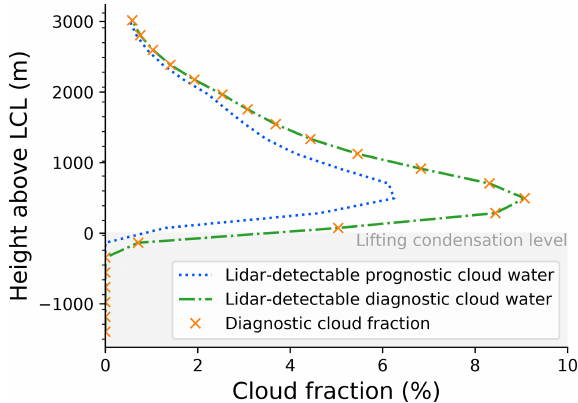
Figure B1. Mean cloud fraction profile for resolved and diagnostic lidar-detectable clouds in the full SRM output. In addition, the cloud fraction profile given by the diagnostic equations is